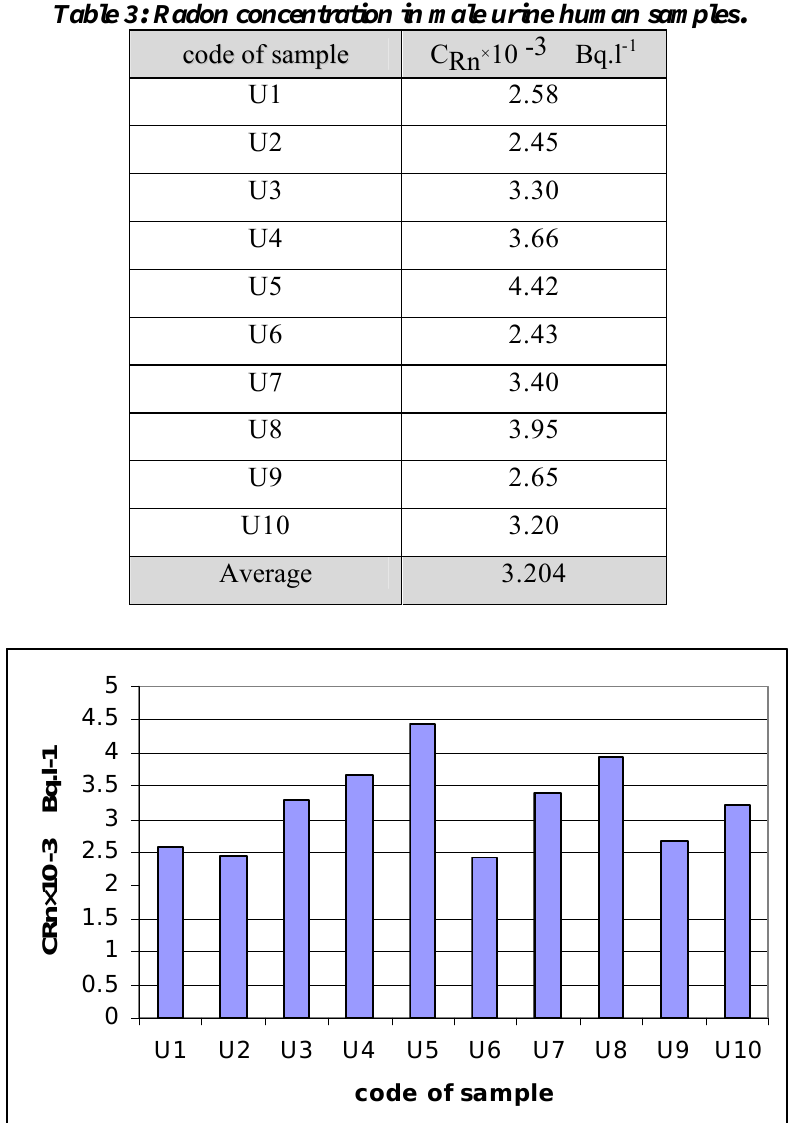
Fig. 4: Radon concentration of male urine human